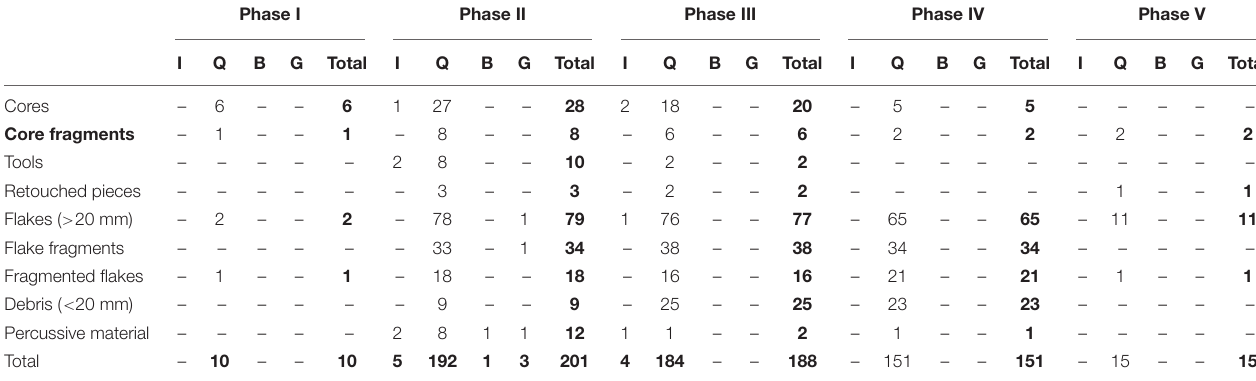
TABLE 1 | Ewass Oldupa lithic distribution by artifact classification, occupation phase, and raw material. Phase